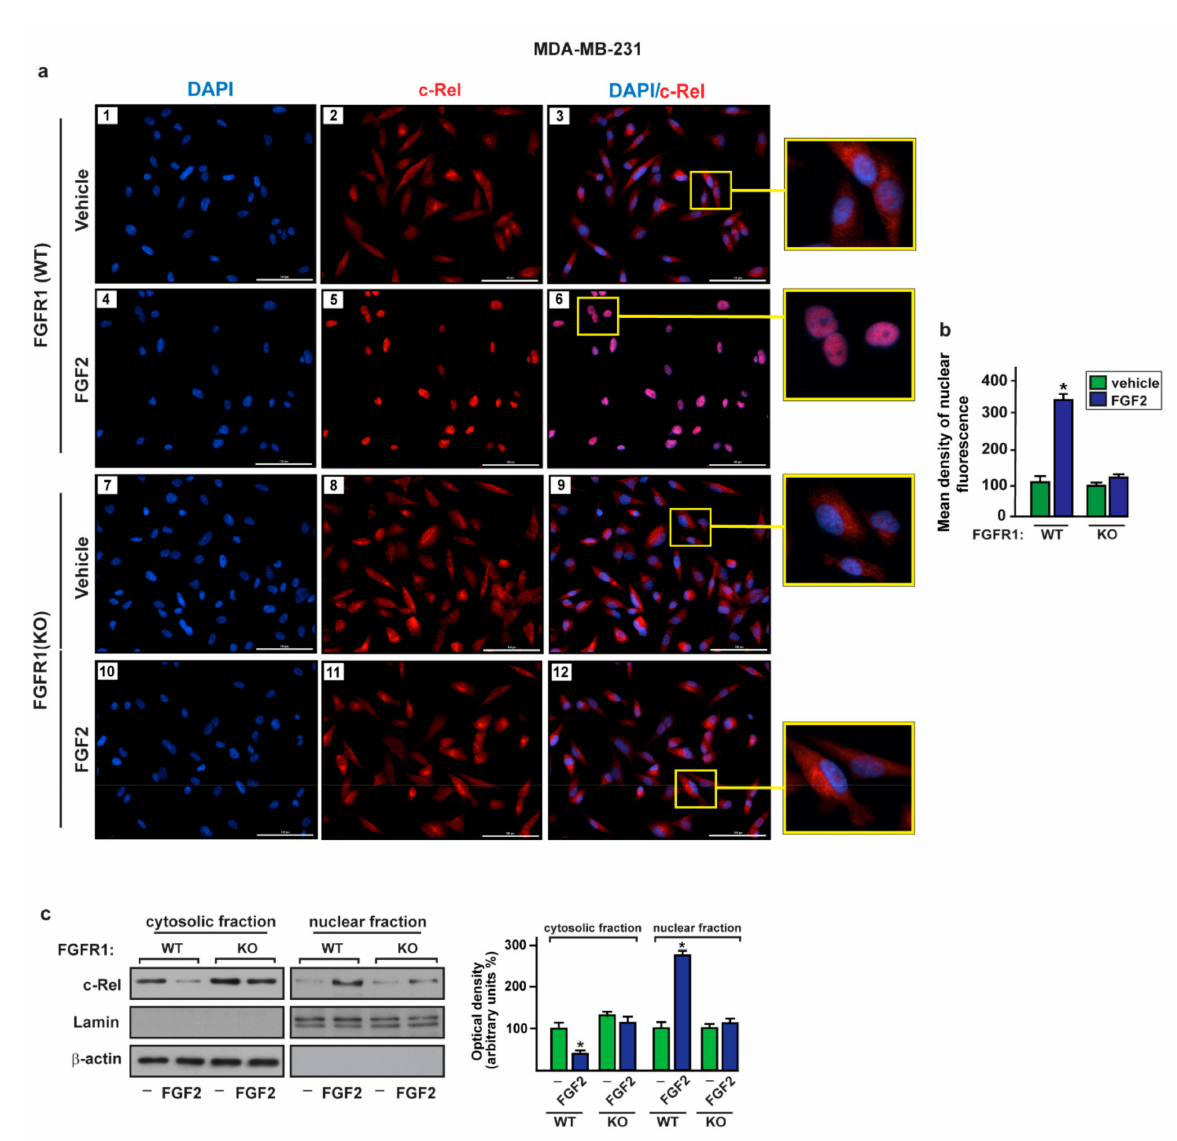
Figure 4. The activation of FGF2/FGFR1 transduction pathway leads to c-Rel nuclear accumulation in MDA-MB-231 cells. ( a ) Immunofluorescence staining of c-Rel in FGFR1 (WT) (panels 1–6) and FGFR1 (KO) (panels 7–12) MDA-MB-231 cells treated for 2h with vehicle and 25 nM FGF2. c-Rel localization is shown in red, nuclei are stained by DAPI (blue), scale bar = 100 µ m. Enlarged details are shown in the separate box. Images shown are representative of two independent experiments. ( b ) Quantification of nuclear c-Rel in cells treated with vehicle versus cells exposed to FGF2, as indicated. ( c ) Immunoblots of cytosolic and nuclear fraction lysates derived from FGFR1 (WT) and FGFR1 (KO) MDA-MB-231 cells treated for 2h with vehicle (-) and 25 nM FGF2, as indicated. β -Actin and lamin were used as cytosolic and nuclear protein markers, respectively. Side panel shows densitometric analysis of the blots normalized to actin (for cytosolic fraction) or to lamin (for nuclear fraction). Values represent the mean ± SD of three independent experiments. (*) indicates p <